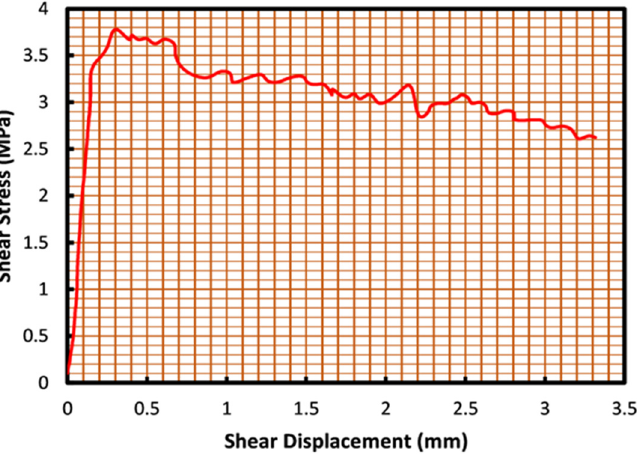
Figure 3. Example of the stress-displacement curve for an epoxy grouted joint with JRC of 17.4 derived through a direct shear test.